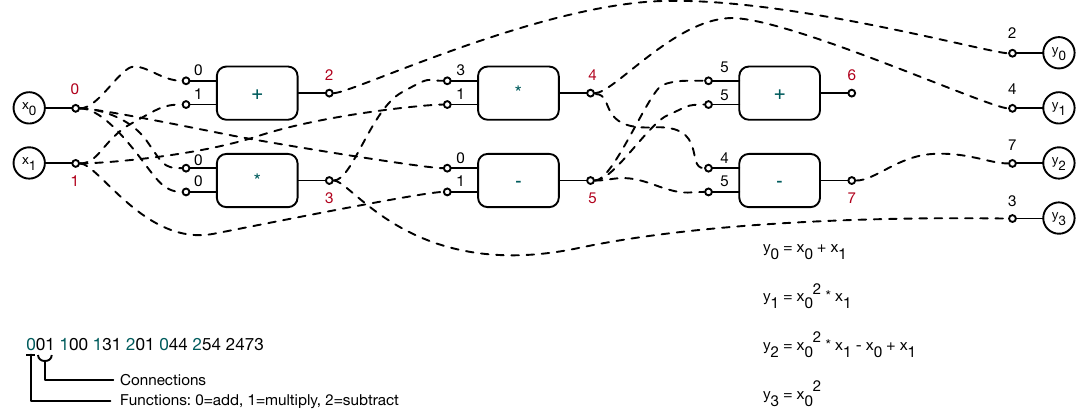
Figure 1. An example of a simple Cartesian Genetic Programming (CPG) network, composed of six nodes arranged in a 2 × 3 rectangular format. The directed graph represents the phenotype, whereas, in the bottom left of the figure, the corresponding genotype is